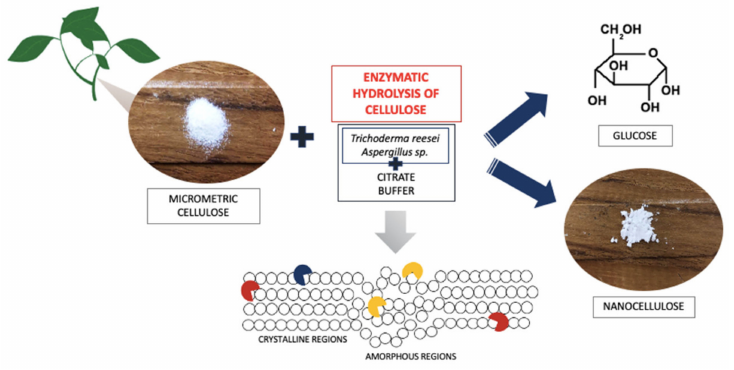
Figure 1. Scheme of the process of enzymatic hydrolysis of cellulose.